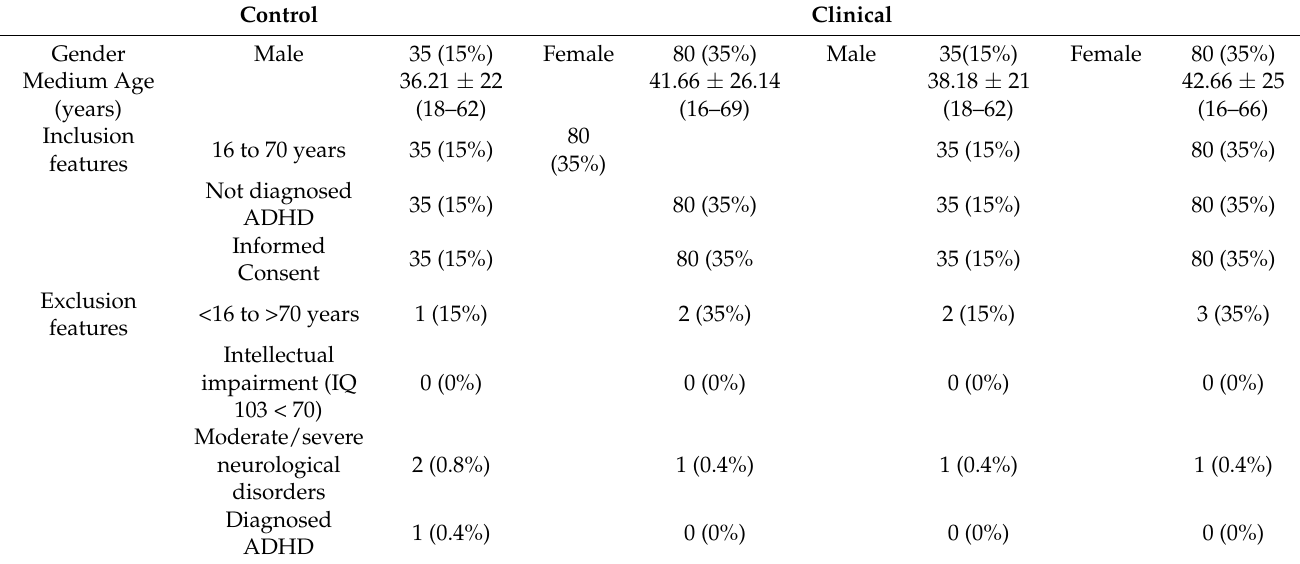
Table 1. Basic characteristics of the control and experimental groups (n = 230; excluded n =